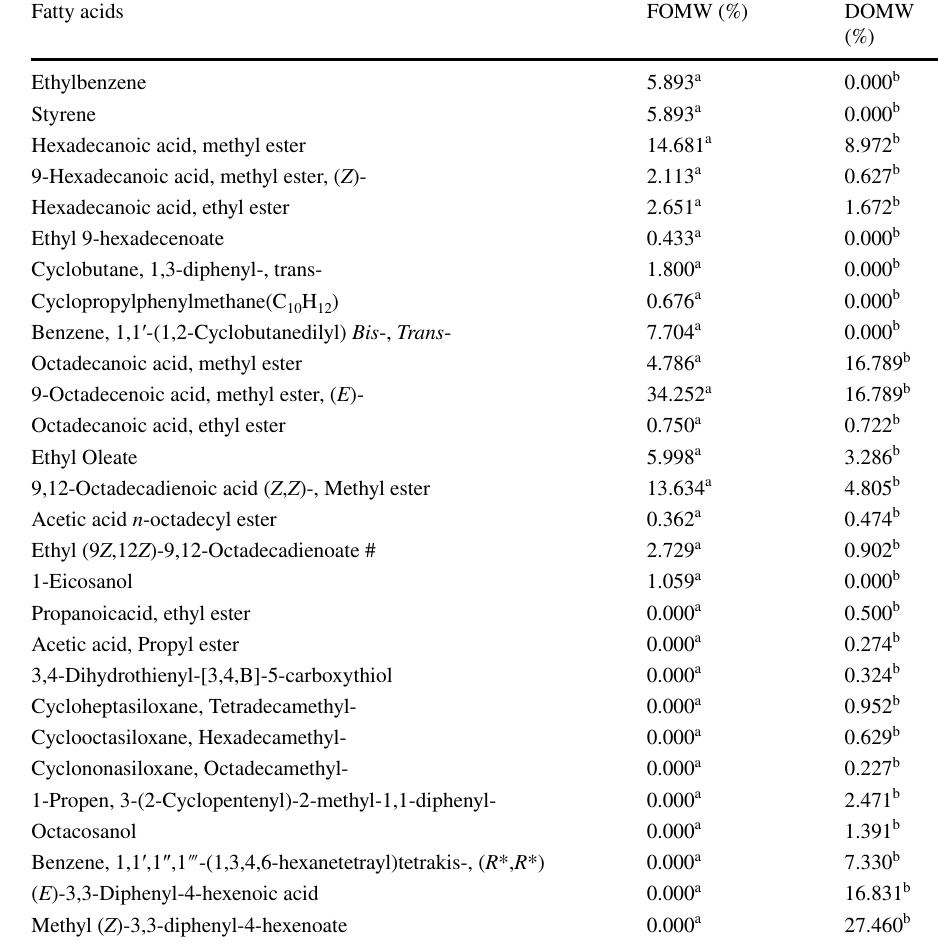
concentration rate in FOMW and